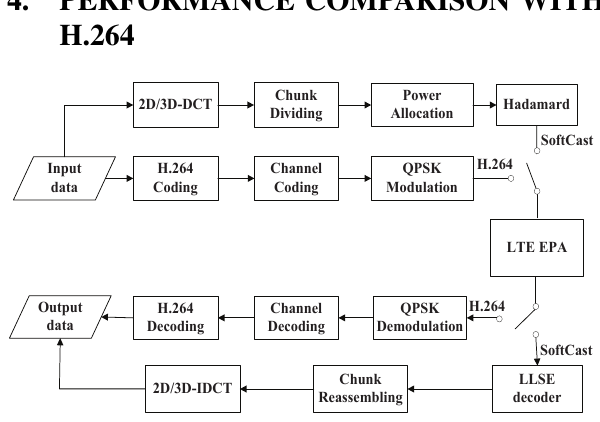
Figure 8: Famework of comparison between Soft- Cast and